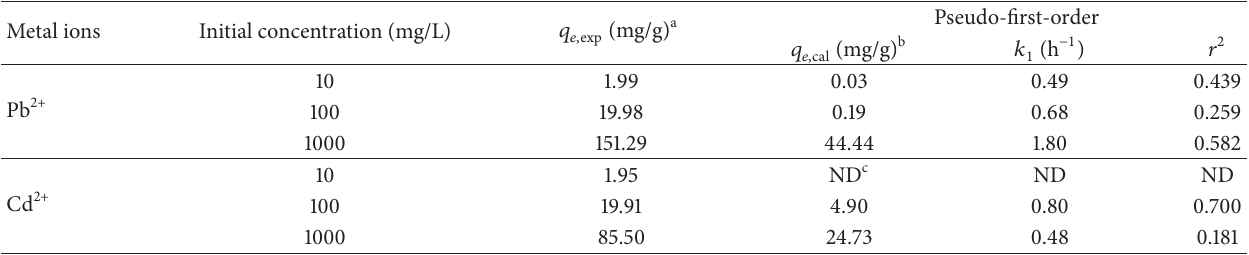
b Determined from Figure 6 via (5). c Not determined. Table 4: Pseudo-second-order kinetic parameters for adsorption of Pb 2+ and Cd 2+ on 30/70 HAp/chitosan hybrid fiber. Metal